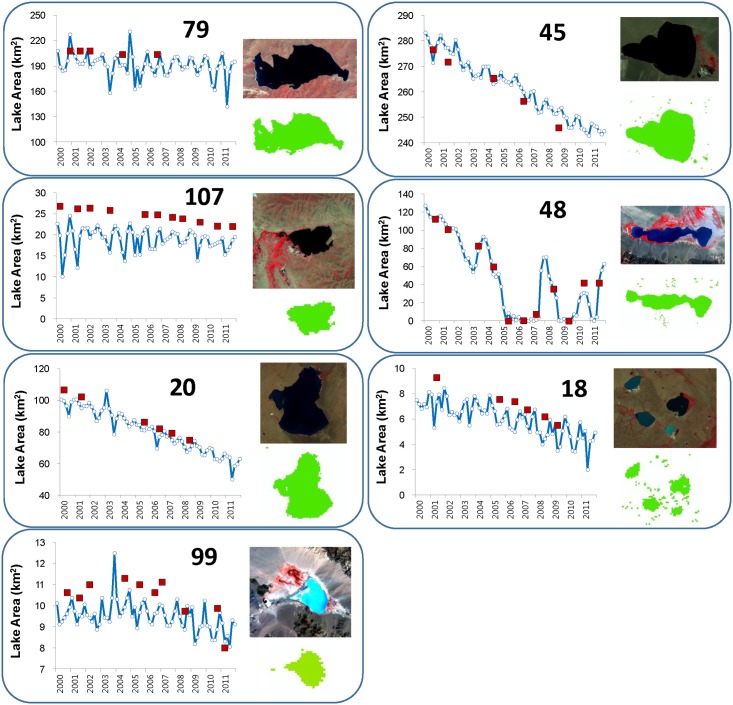
Lake area (km2) timeseries from 2000 to 2011.Filled squares and open circles indicate lake areas from Landsat TM/ETM+ and MODIS09GQ, respectively. Upper and lower keymaps show lake water pixels from Landsat and MODIS, respectively. Numbers at the top of each figure are the lake ID numbers shown in Fig 1.